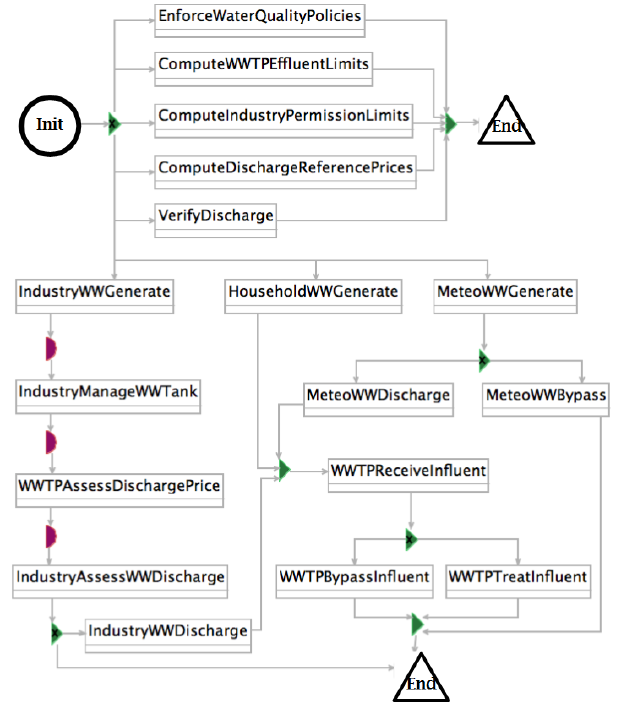
Figure 3. General scene pattern. It defines scenes that describe how agents coordinate and how transitions are performed from one scene to another. Table 1. Scenes and role